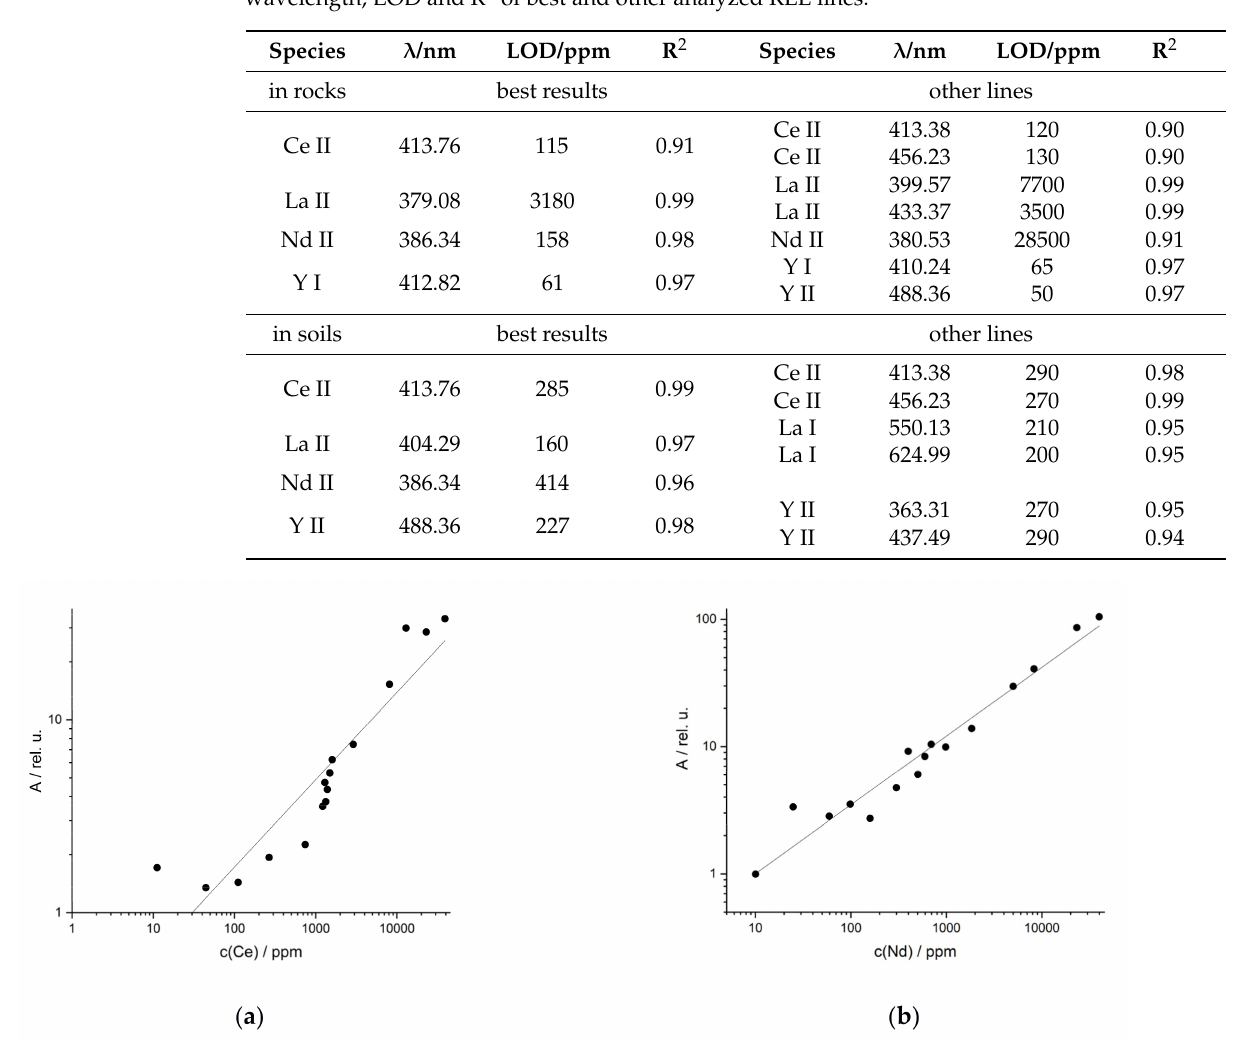
Table 2. Results of univariate regression of synthetic samples of REE (Ce, La, Nd, Y) in rock and soil: wavelength, LOD and R 2 of best and other analyzed REE lines.